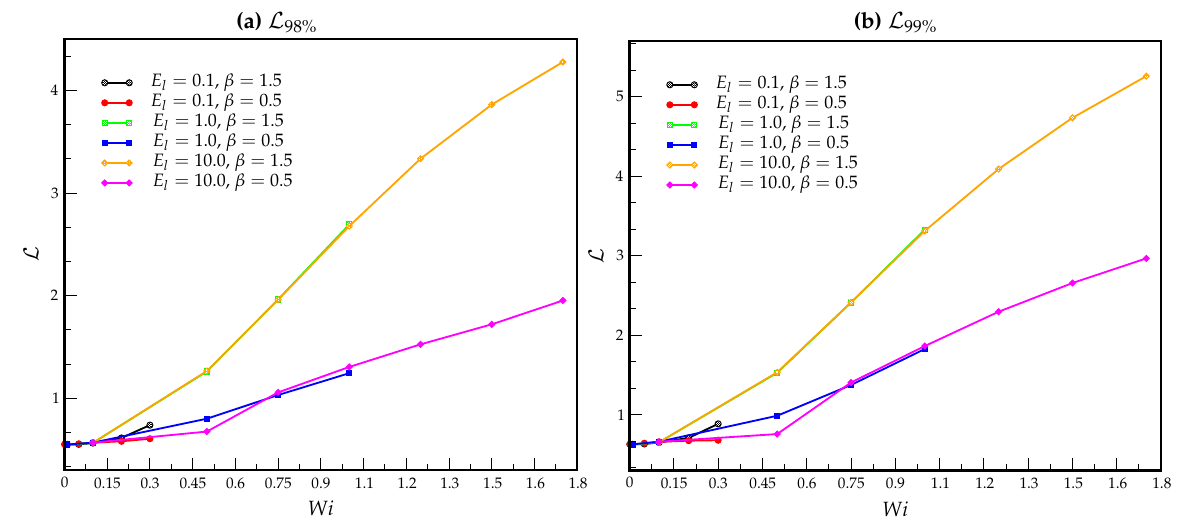
Figure 13. Influence of the Elasticity number, El = Wi , on the development length of the gPTT model. We consider three different values of El (0.1, 1, 10), α = 0.5 and two different values of β , 0.5 and 1.5.